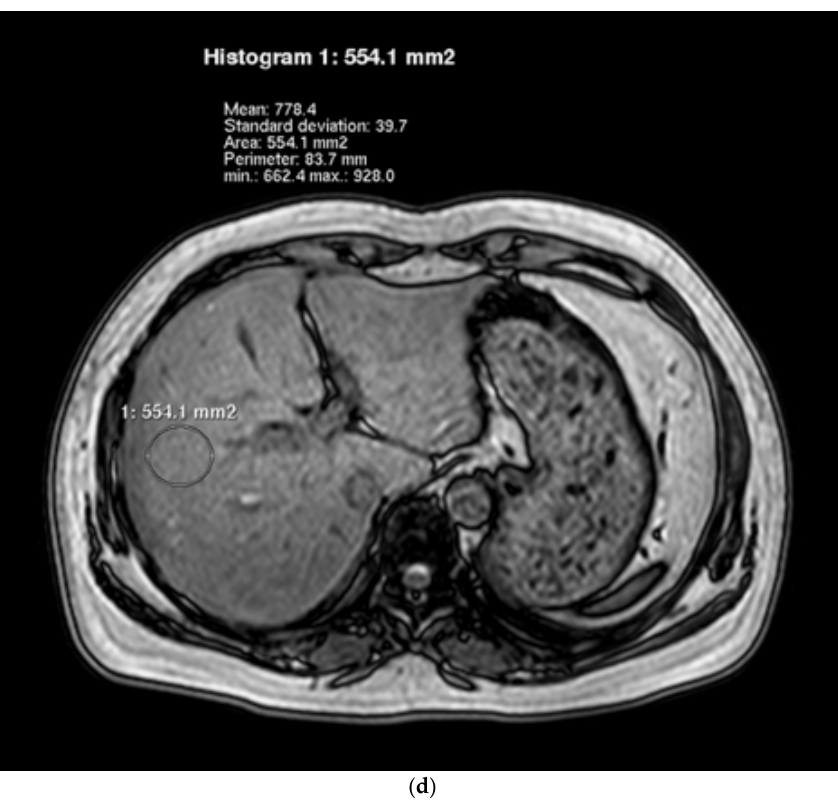
Figure 1. Representative IP ( a , c ) and OP ( b , d ) images of livers obtained by using dual ‐ echo sequence. Images of a NAFLD patient and a healthy individual were, respectively, Figure 1a–d.